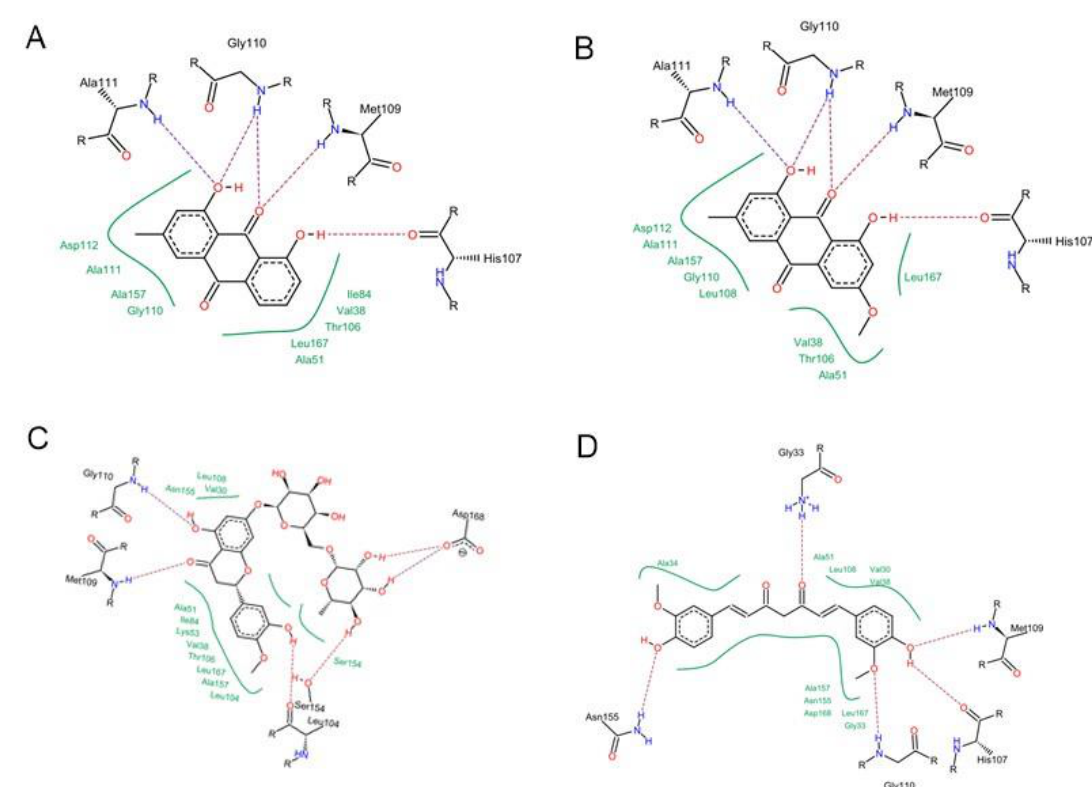
Figure 7. 2D Protein-ligand binding diagram of chrysophanol ( A ), physcion ( B ), hesperidin ( C ) and curcumin ( D ) with p38α MAPK (PDB ID: 2QD9).